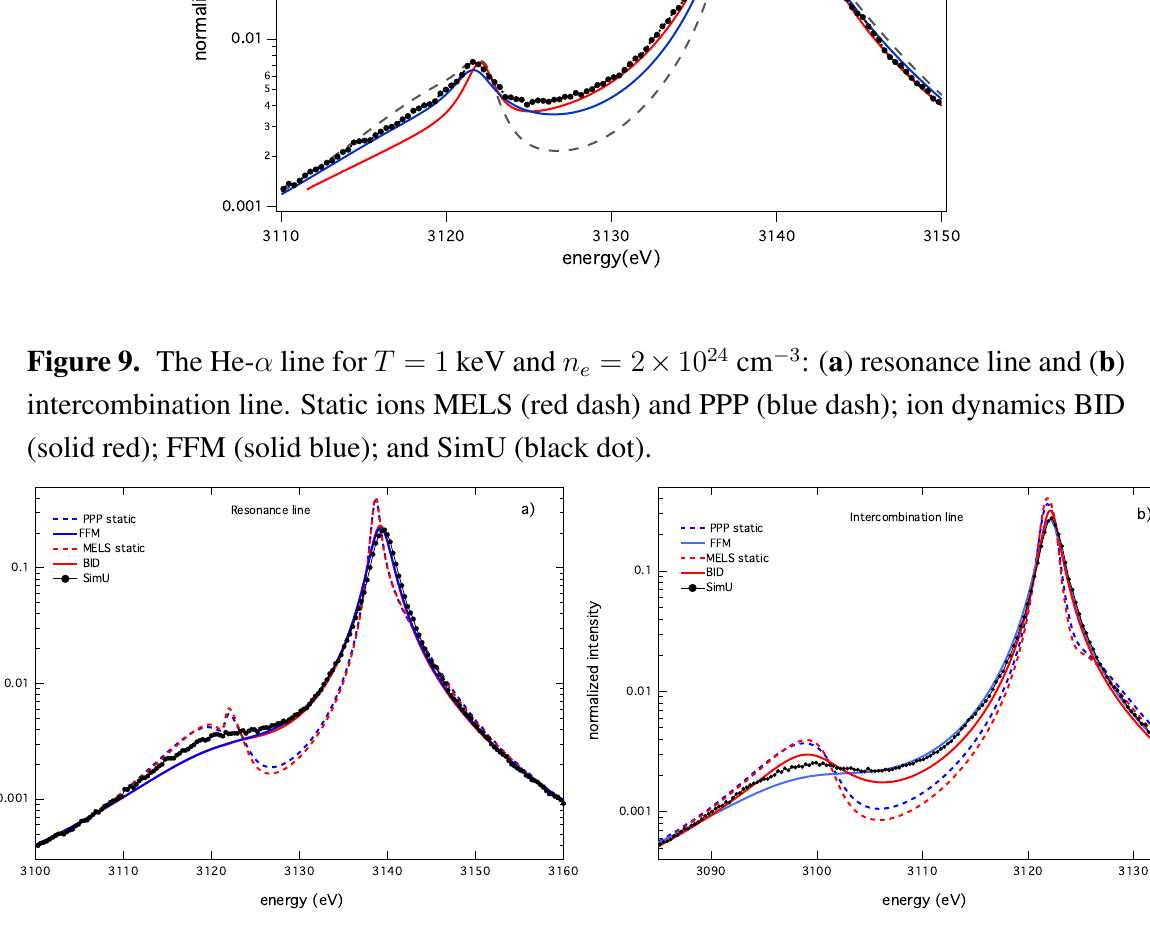
= 2 (cid:2) 10 24 cm (cid:0) 3 : static ions (grey dash); e